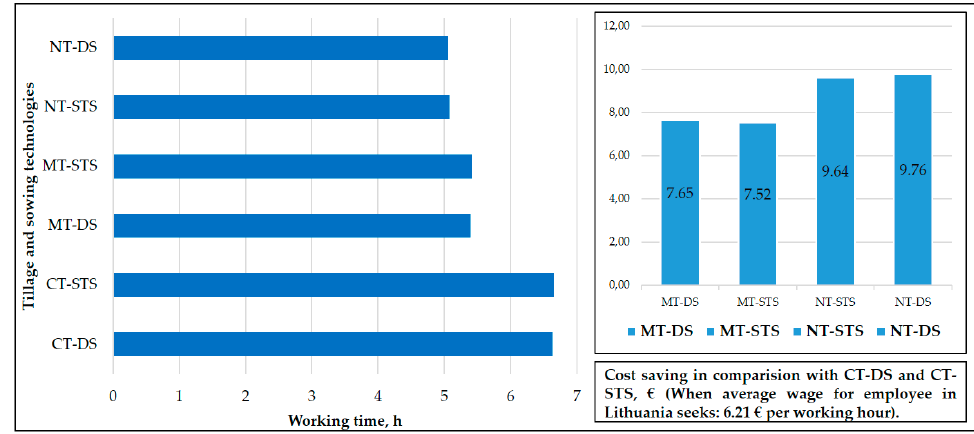
Figure 4. Time inputs in different tillage and sowing technologies.